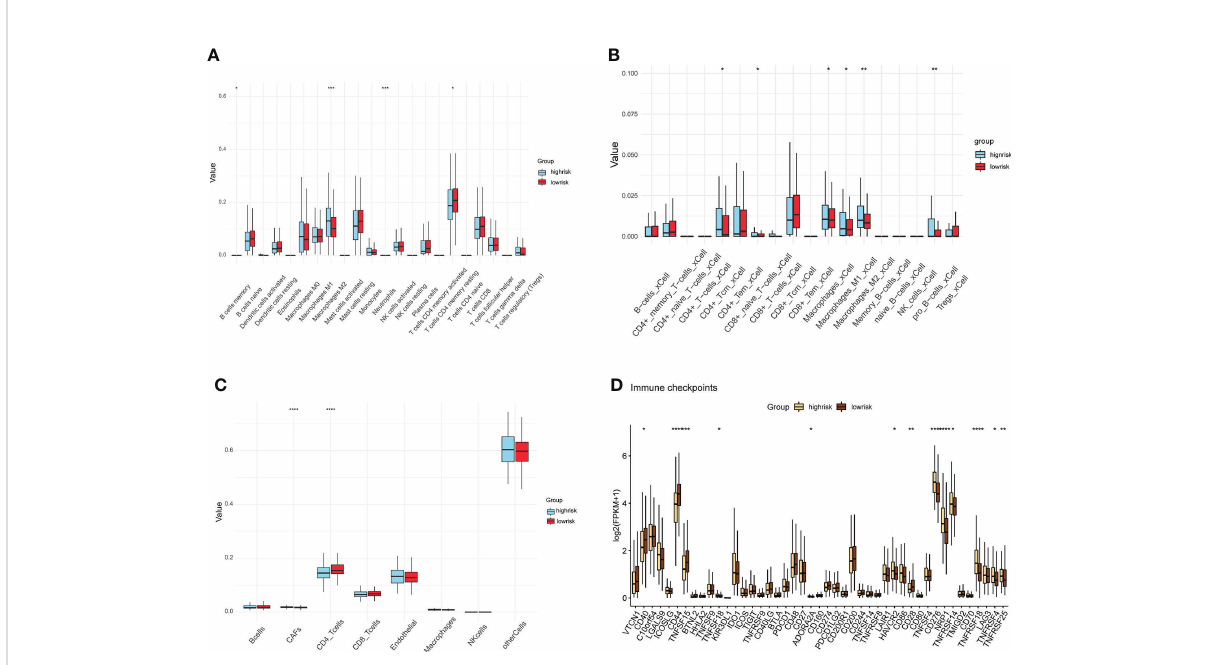
FIGURE 5 Differences in immune cell in fi ltration and immune checkpoints. (A – C) Assessment of tumor microenvironment and immune cell in fi ltration by methods CIBERSORT (A) , xCell (B) , and EPIC (C) in HS and LS groups. (D) differences analysis of immune checkpoints between HS and LS groups. (*P < 0.05, **P < 0.01, ***P < 0.001, ****P <